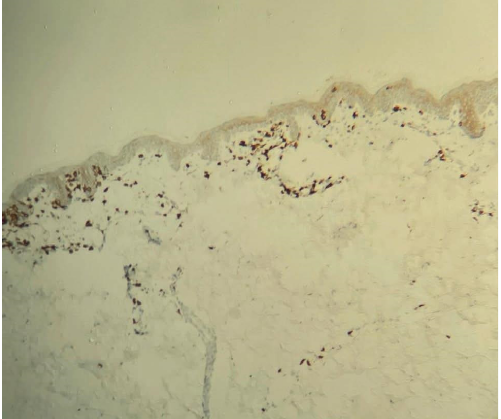
Figure 4: Immunohistochemical staining showing CD 8+ T cells.